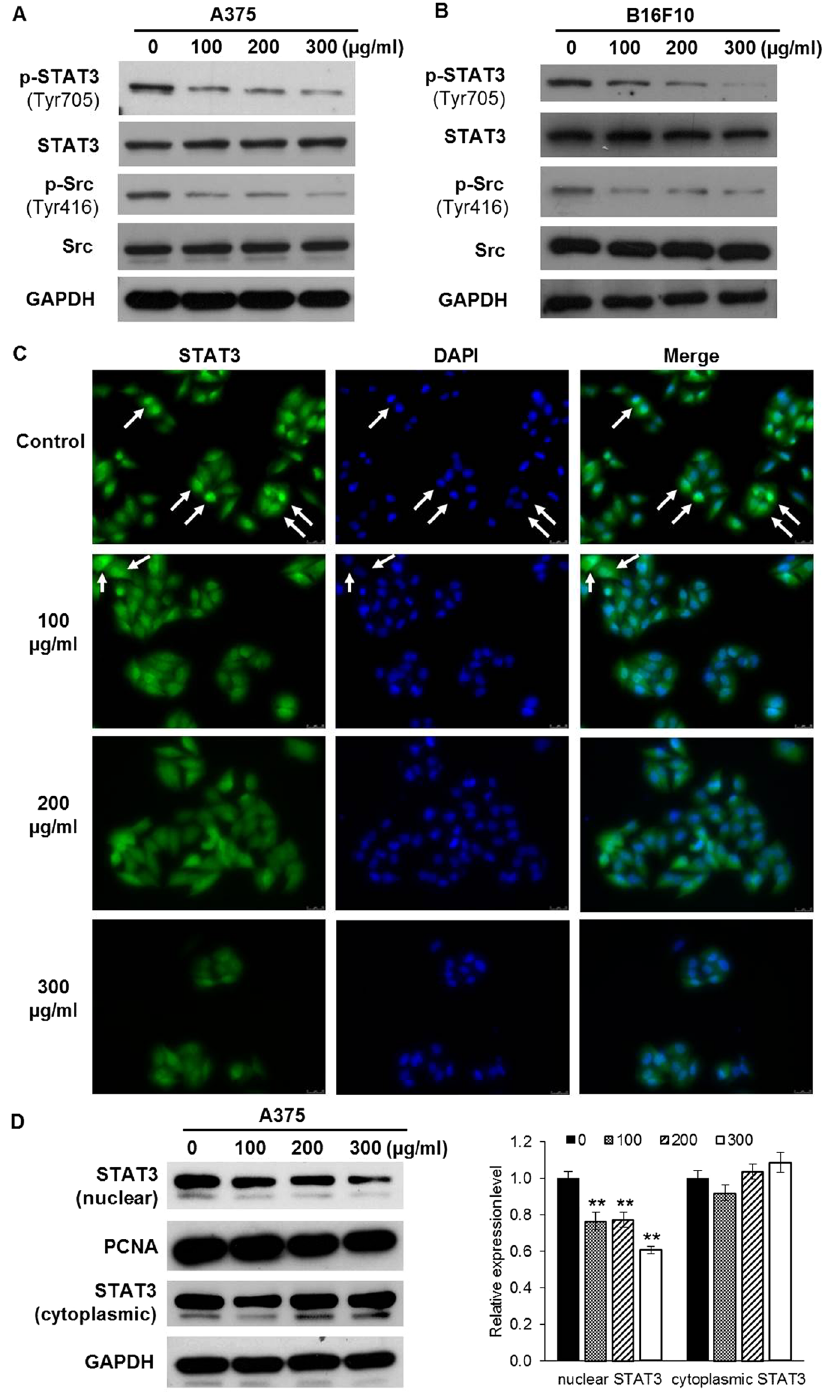
Figure 5. SLE suppressed STAT3 and Src phosphorylation, and STAT3 nuclear localization in melanoma cells. ( A ) The expression levels of phospho-STAT3 (Tyr705), STAT3, phospho-Src (Tyr416) and Src in A375 ( A ) and B16F10 ( B ) cells. Cells were treated with the indicated concentrations of SLE for 48 h. Protein levels were examined by immunoblotting. GAPDH was used as a loading control. ( C ) Immunofluorescence staining of STAT3 in A375 cells treated with SLE for 48 h. Cells were fixed and labeled with STAT3 antibody and counterstained with DAPI. ( D ) Immunoblot analysis of STAT3 levels in cytoplasmic and nuclear fractions of A375 cells treated with SLE for 48 h (left panel). GAPDH represents a loading control for the cytoplasmic fraction, and PCNA represents a loading control for the nuclear fraction. Relative protein levels were analyzed by Image J software (right panel). Results were shown as mean ± SD from three independent experiments, ** P < 0.01. The corresponding western blot images represented were cropped sections and the original images were shown in Supplementary